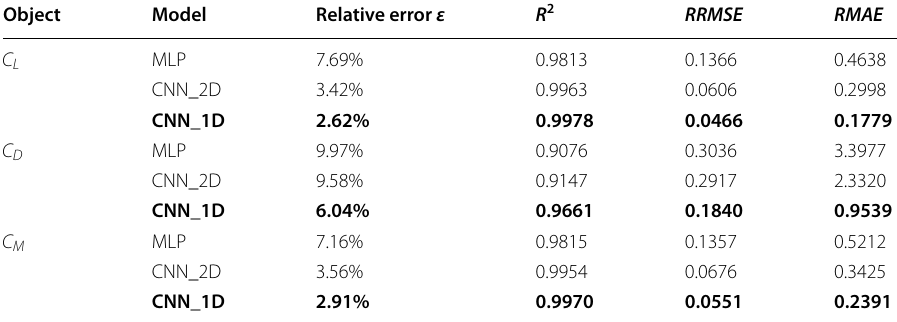
Table 7 Comparison of accuracy metrics for predictions of aerodynamic performance by MLP, CNN_2D, and CNN_1D in high‑dimensional aerodynamic modeling for flight status and wing shape variables